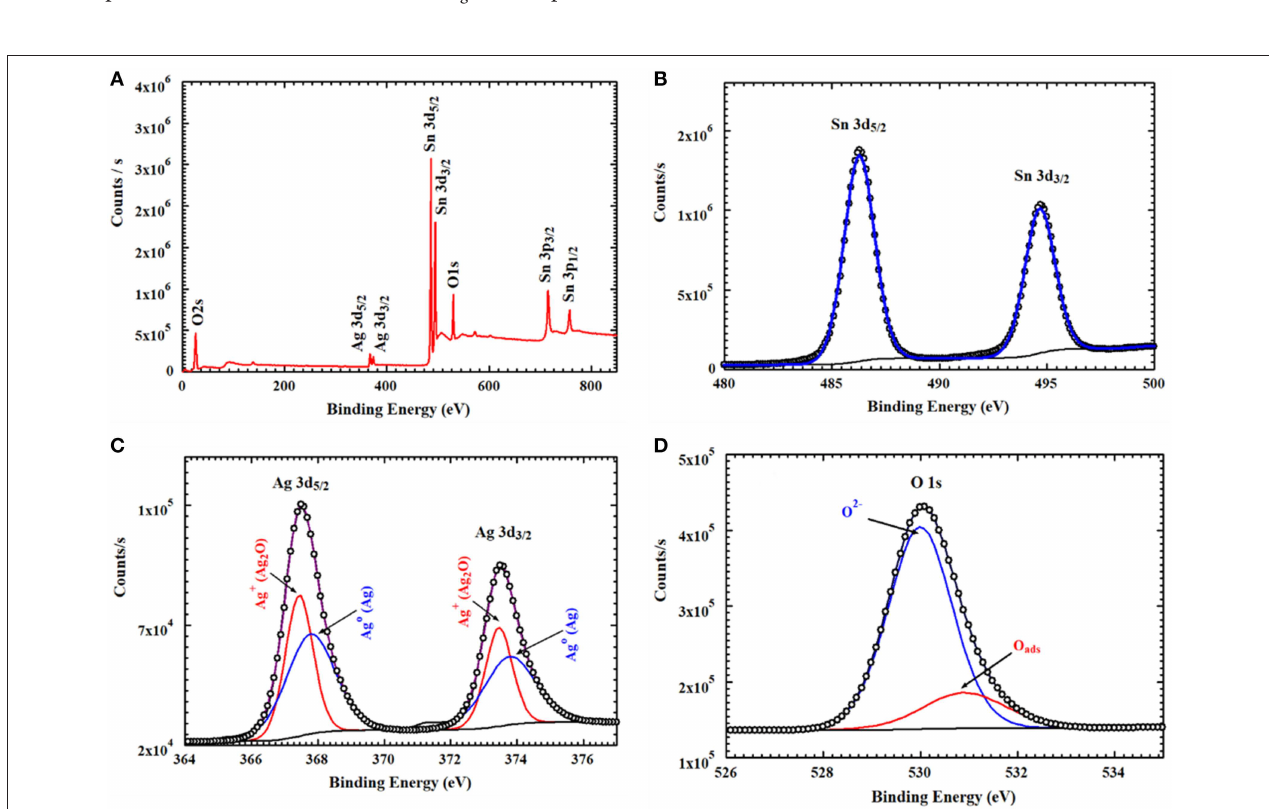
FIGURE 5 | XPS spectra of AgNPs/SnO 2 (A) survey spectrum, (B) XPS peaks of Sn3d, (C) XPS peaks of Ag 3d, and (D) XPS peaks of O1s.